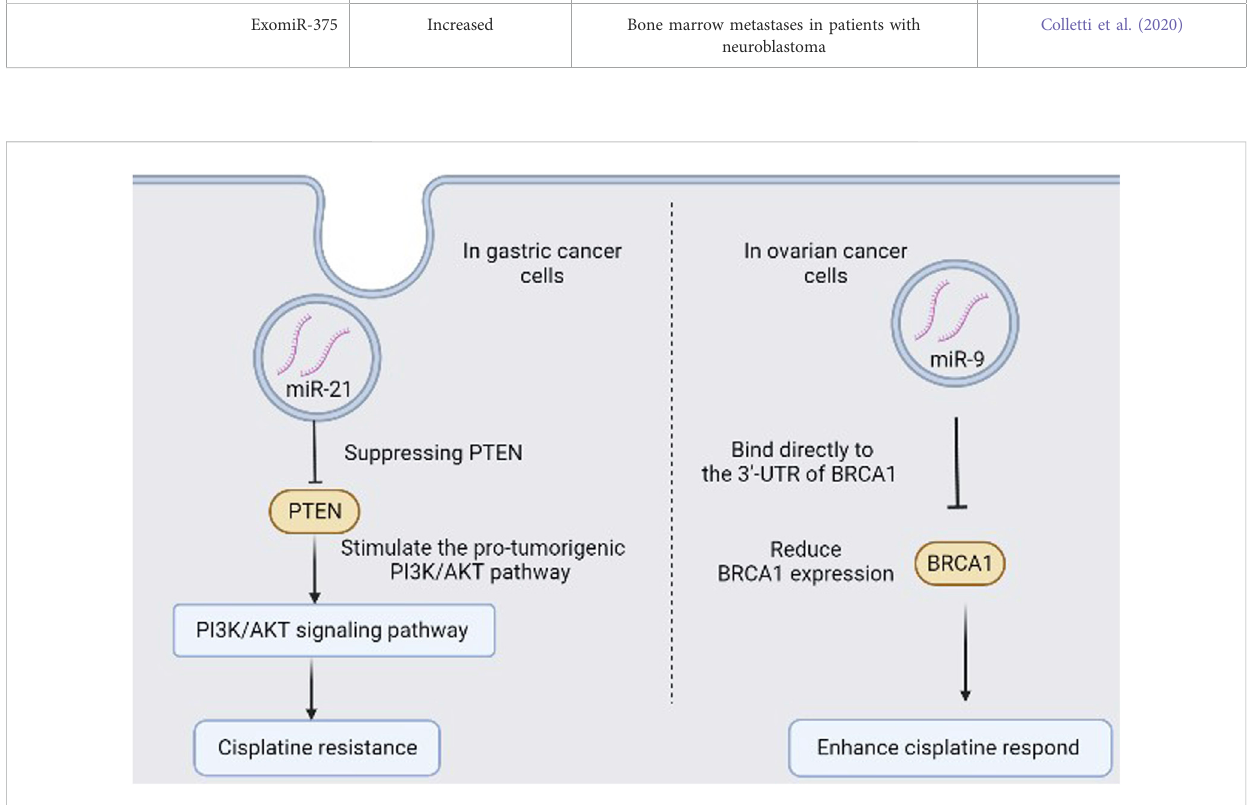
FIGURE 2 Schematic for two examples of exomiRs in drug response/drug resistance in